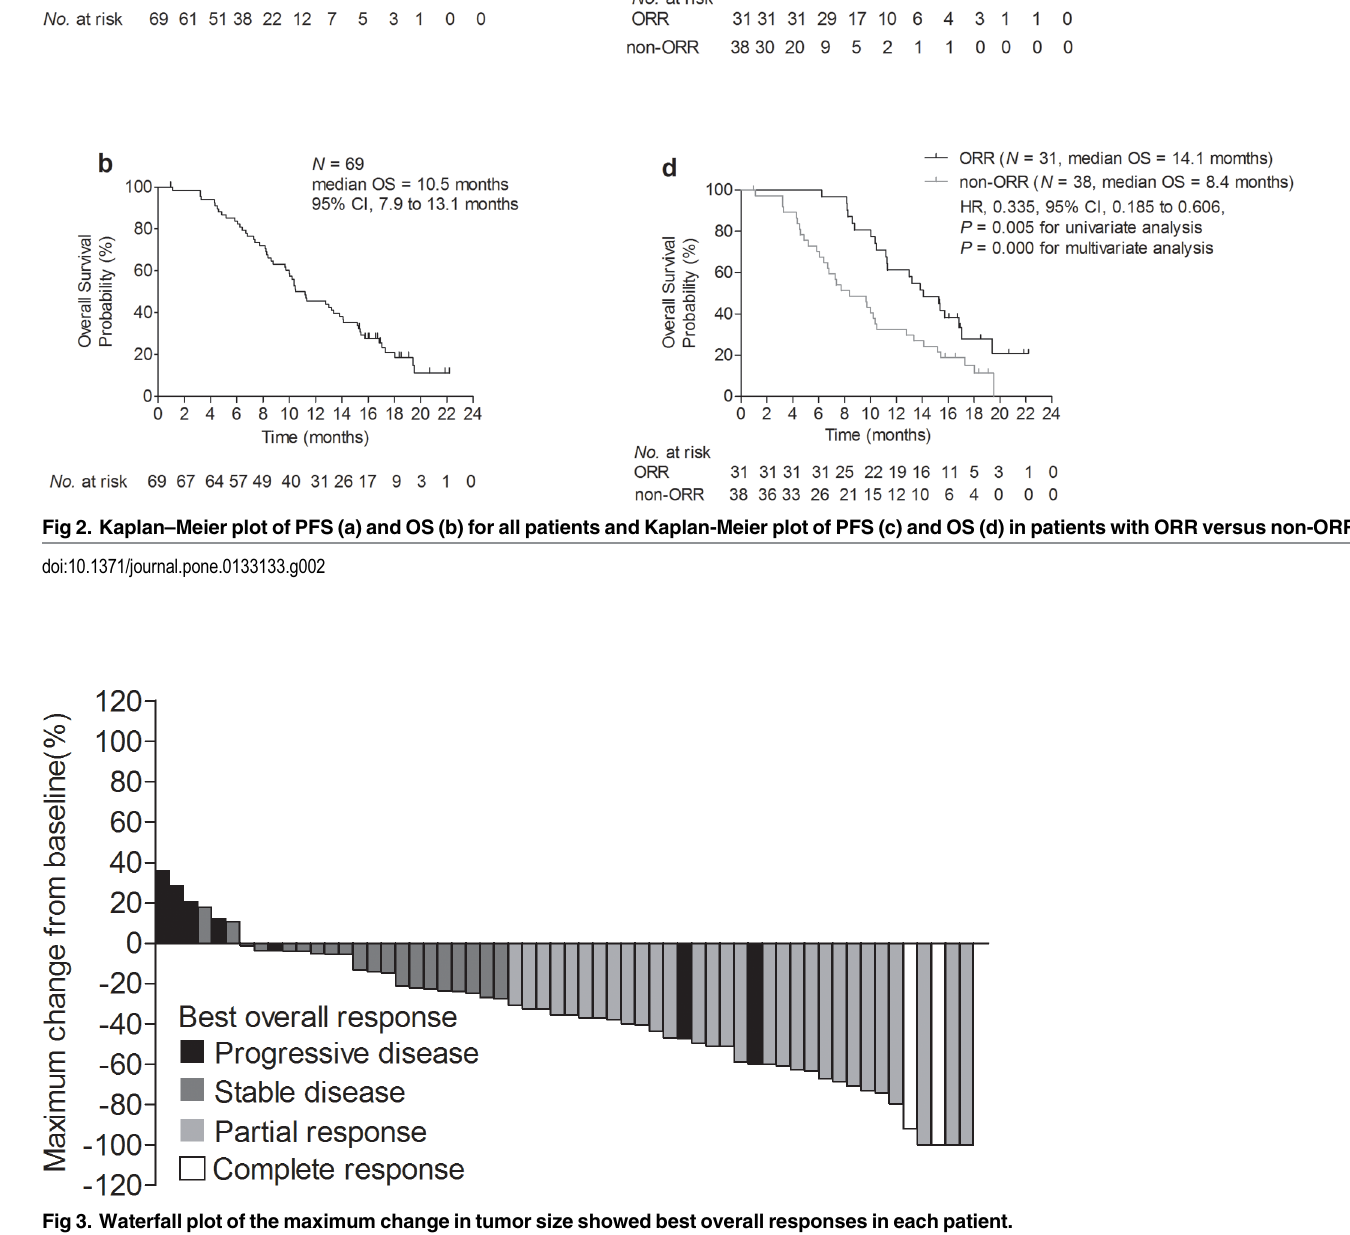
PLOS ONE | DOI:10.1371/journal.pone.0133133 July 17,